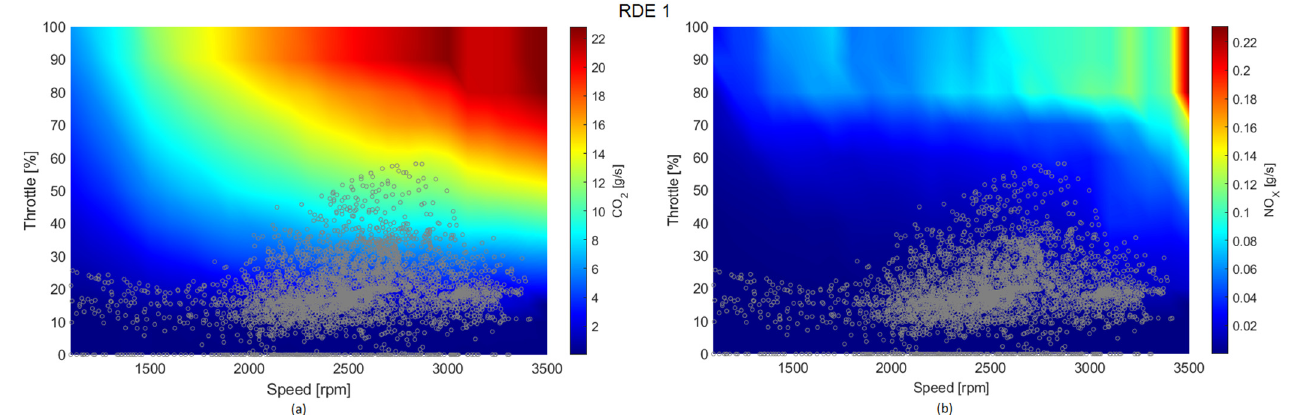
Figure 10. CO 2 [g/s] ( a ) and NO X [g/s] ( b ) emission from engine maps (color scale) and those obtained from the tested cycle (dots).